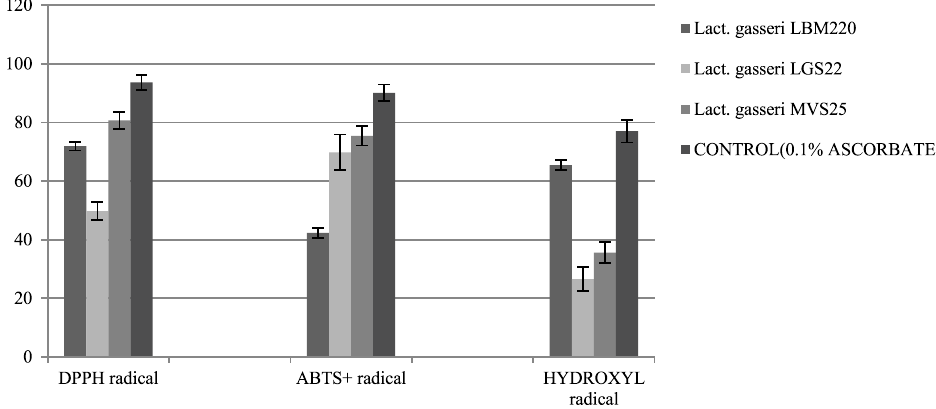
Fig. 3. Percentage free radicals scavenging potential of Lact. gasseri strains from infant faeces and human milk Scavenging effect on hydroxyl radicals, DPPH free radicals and ABTS+ radicals by culture supernatant of Lact. gasseri strains incubated at 25°C . Each value is expressed as mean ± S.D. (n = Table 1. Resistance of Lact. gasseri strains at different hydrogen peroxide concentrations Isolates